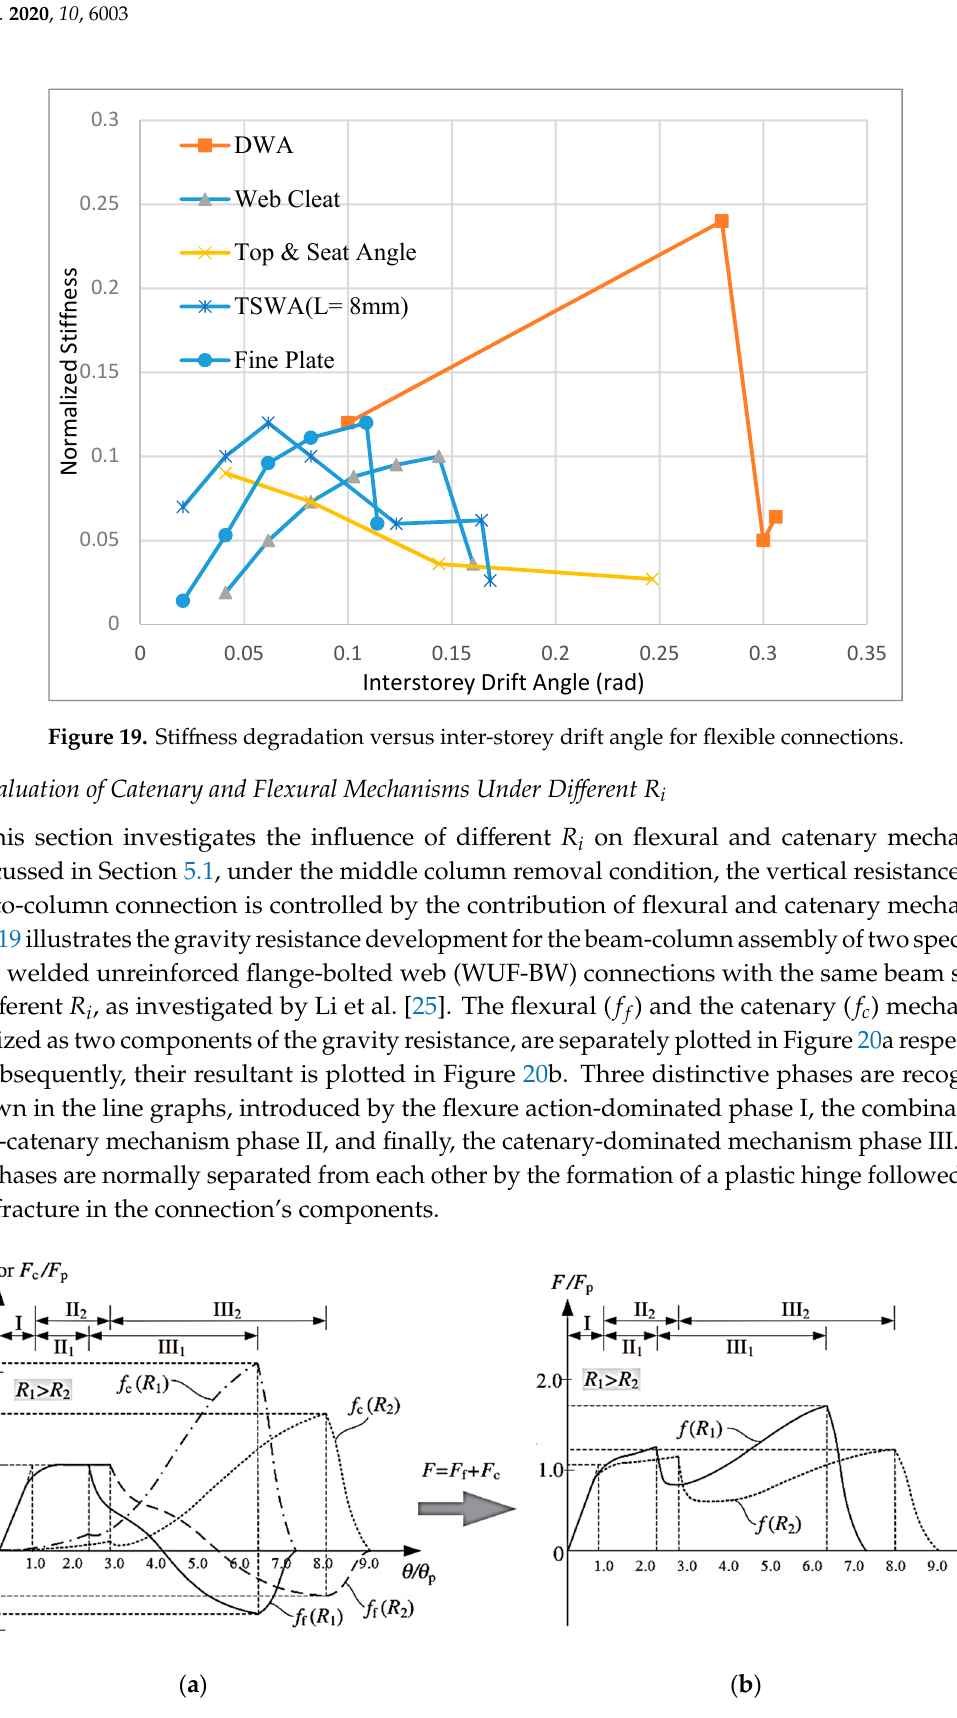
Figure 20. Gravity resistance development for beam-to-column assembly: ( a ) flexural and catenary mechanism, and ( b ) overall gravity resistance.